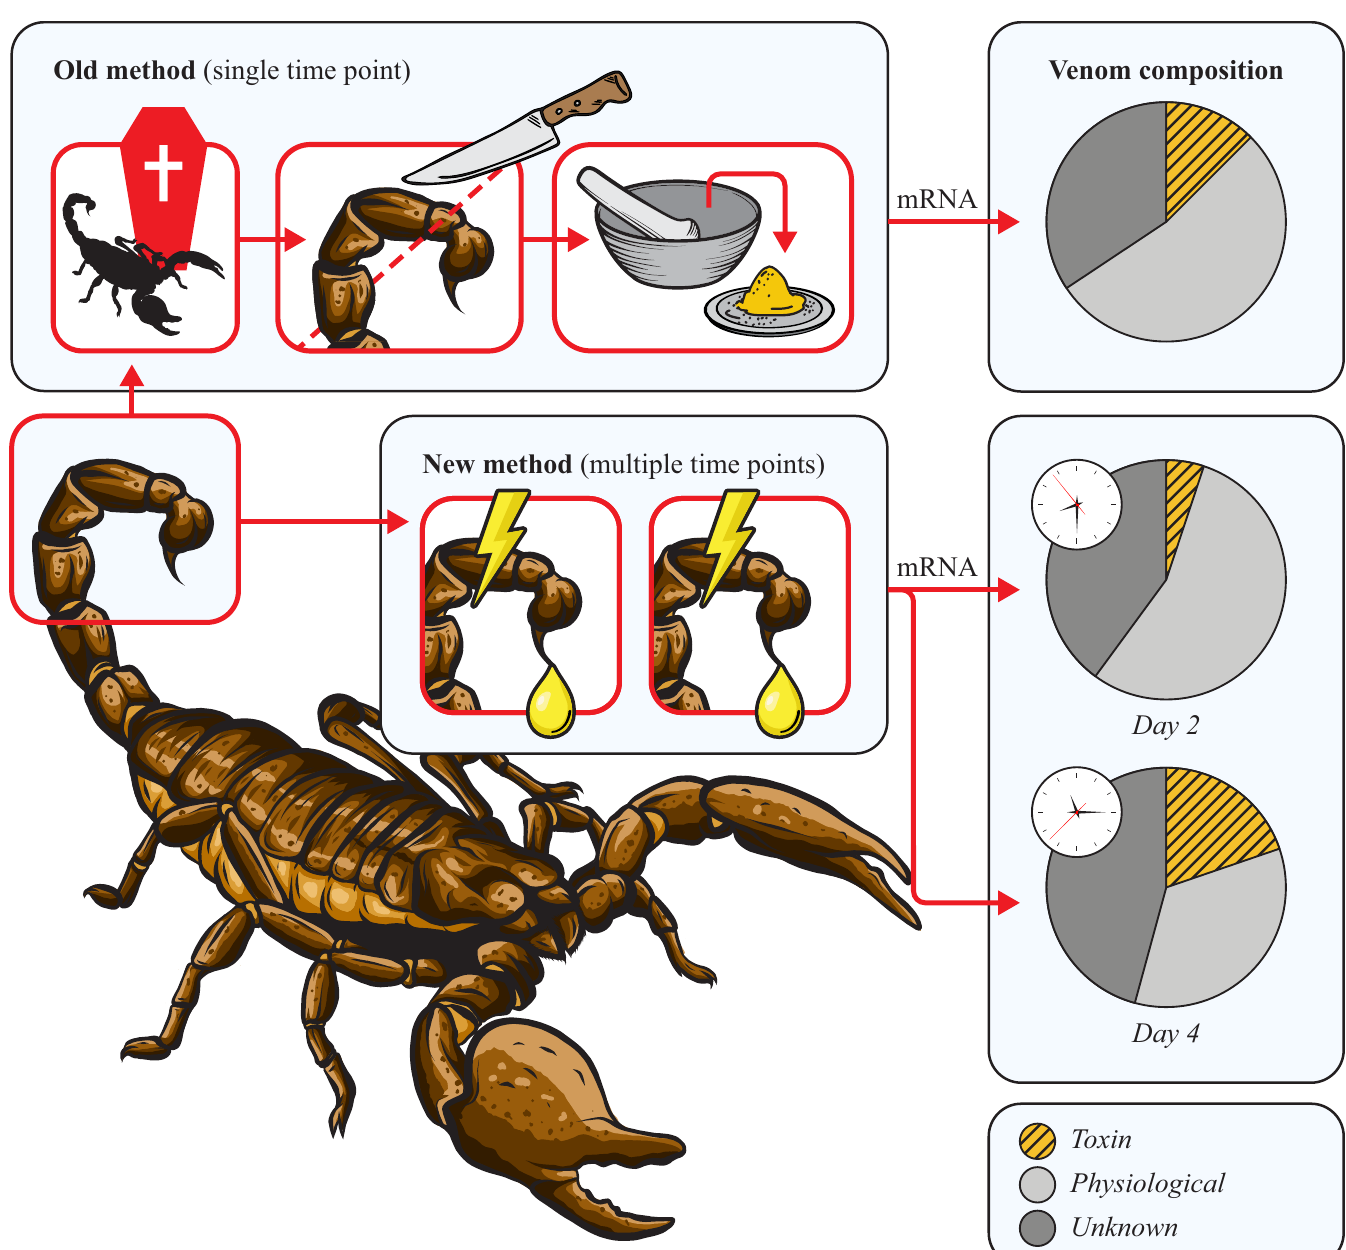
Fig 1. Schematic overview of the old method and the here presented new method for the generation of venom gland transcriptomes. Comparison between the ‘traditional’ method and our newly developed method for the extraction of mRNA from the Vietnam forest scorpion ( Heterometrus laoticus ). The traditional method involves sacrificing the animal to extract the venom gland from the telson or to homogenize the entire telson in order to collect mRNA, whereas the newly developed method includes mRNA-extraction from scorpion venom, which overcomes the need of harming the animal.